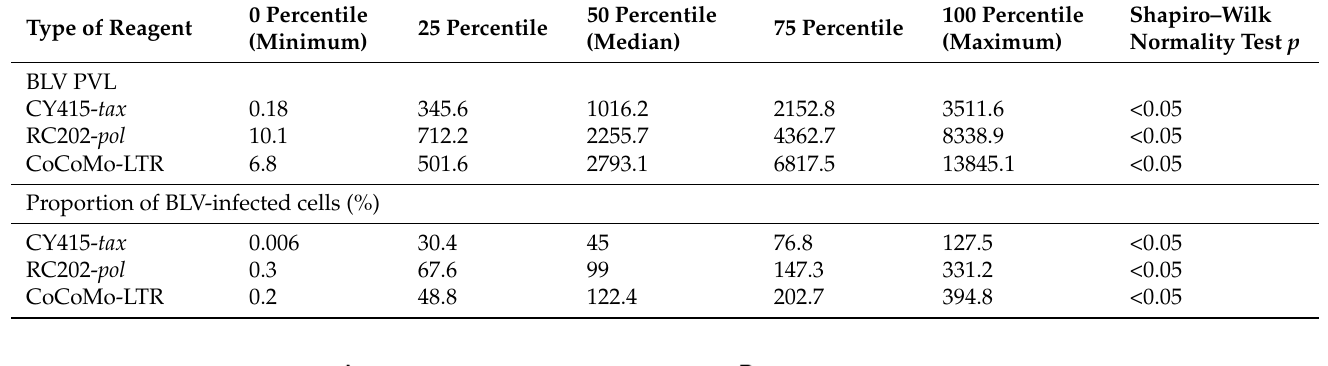
Table 2. Descriptive statistics for bovine leukemia virus (BLV) proviral load (PVL) and the proportions (%) of BLV-infected cells from 32 tumor samples, as determined by using the three different qPCRs.